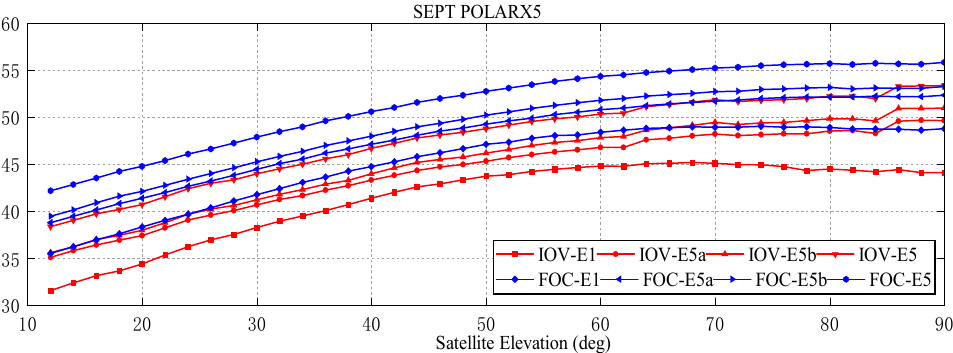
Figure 3. C/N0 values of Galileo signals against the satellite elevation for the receiver TRIMBLE NETR9 ( a ): IOV, ( b ): FOC.